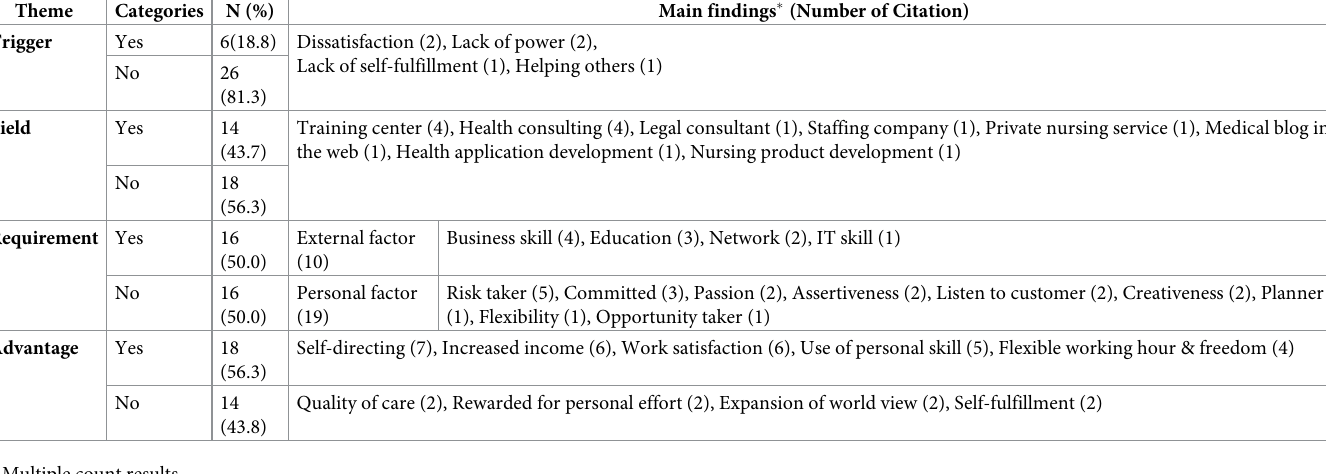
Table 1. Summary of start-up content analysis of YouTube (n =